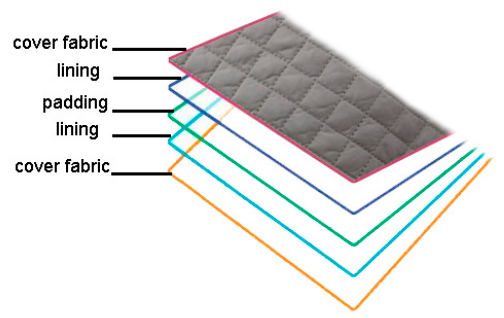
Figure 2. Double-faced, diamond-shaped quilted lining. Table 1. Overview of the analysed technical characteristics of the sample of the integration material.